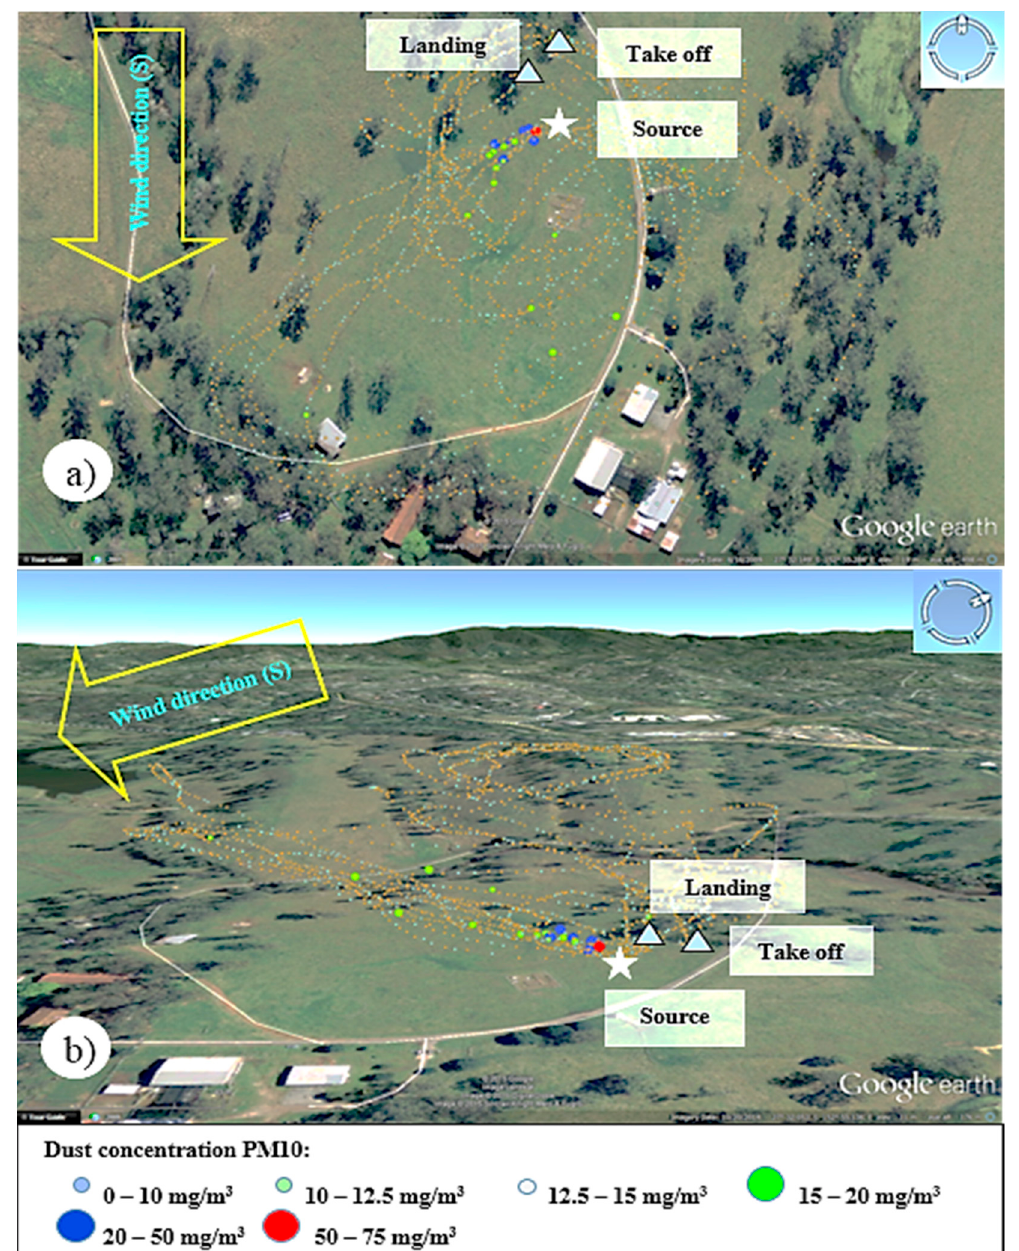
Figure 13. 3D visualization of Test 2 data collected with Teklite-SHARP sensor for PM10 ( a ) Overview and ( b ) Side